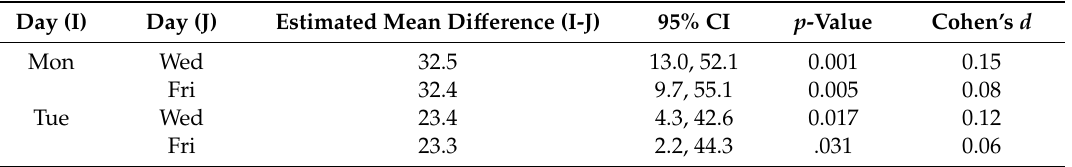
Table A6. Pairwise comparisons of significant estimated mean di ff erences in time in bed (minutes) between weekdays A .